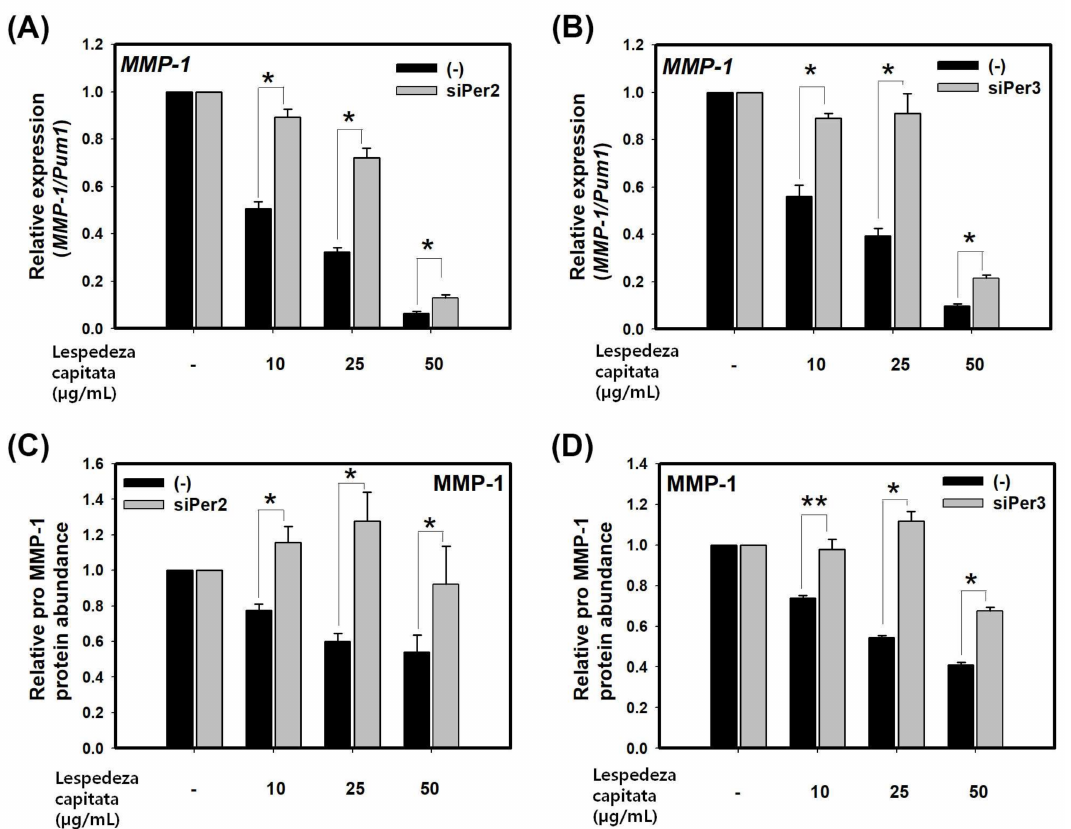
Figure 4. LCE suppresses the expression of MMP-1 through PER in HaCaT cells. Levels of MMP-1 transcripts ( A ) and pro MMP-1 protein ( C ) in HaCaT cells treated with control-siRNA and siPer2 for 48 h followed by treatment with LCE for 24 h. Levels of MMP-1 transcripts ( B ) and pro MMP-1 protein ( D ) in HaCaT cells treated with control-siRNA and siPer3 for 48 h followed by treatment with LCE for 24 h. Data are presented as mean ± SEM from three replicate measurements. Data is the relative value compared with respective control group (control-siRNA or siPer3 at DMSO) (one-way ANOVA, followed by Dunnett T3 post hoc, n = 3, * p < 0.05, ** p < 0.01 compared with control-siRNA at indicated